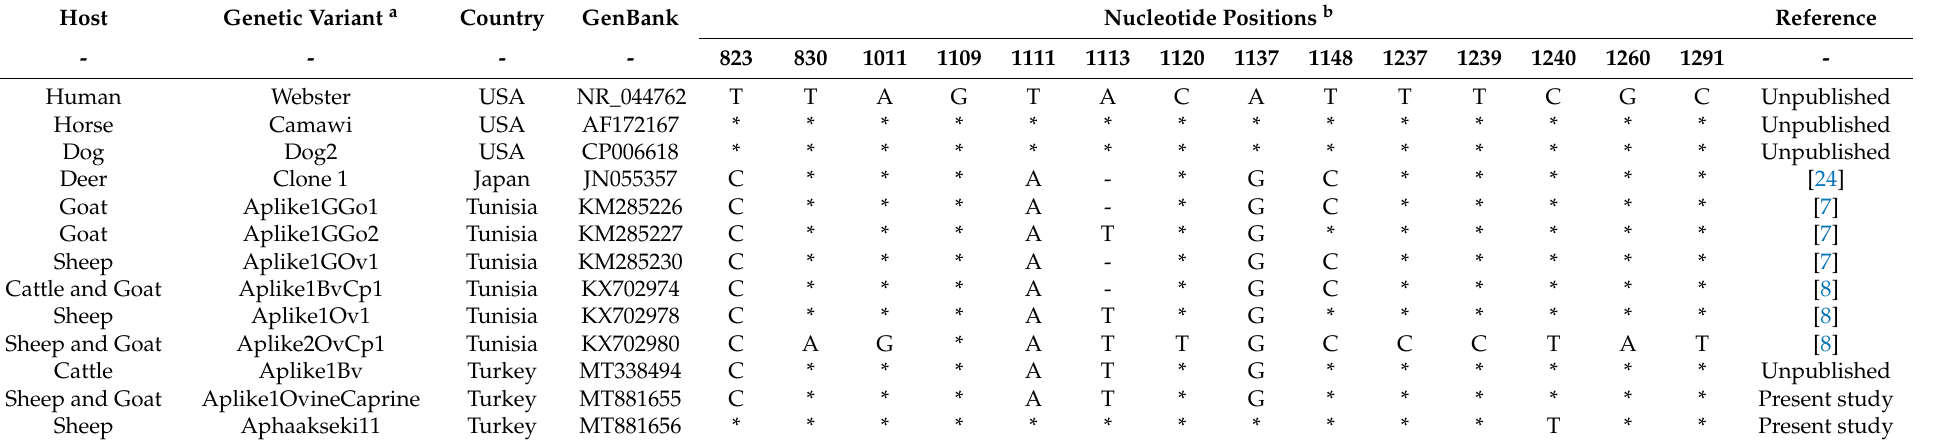
Table 4. Nucleotide differences among 16S rRNA sequences from Anaplasma variants related to A. phagocytophilum (598–599